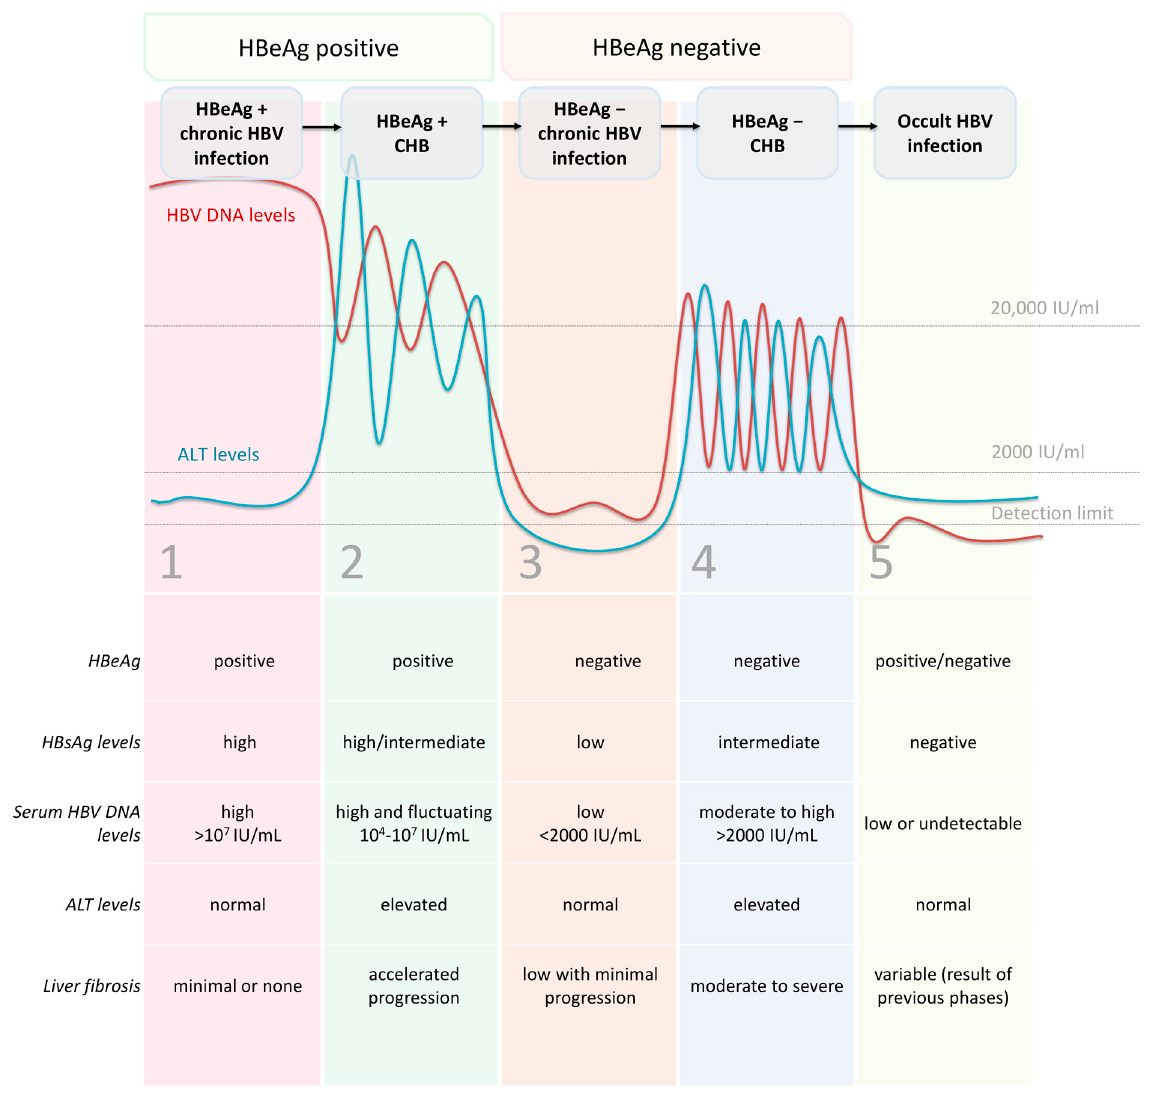
Figure 1. The natural history of chronic HBV infection according to the European Association for the Study of the Liver (EASL). The five phases are not necessarily successive. CHB: chronic hepatitis B.